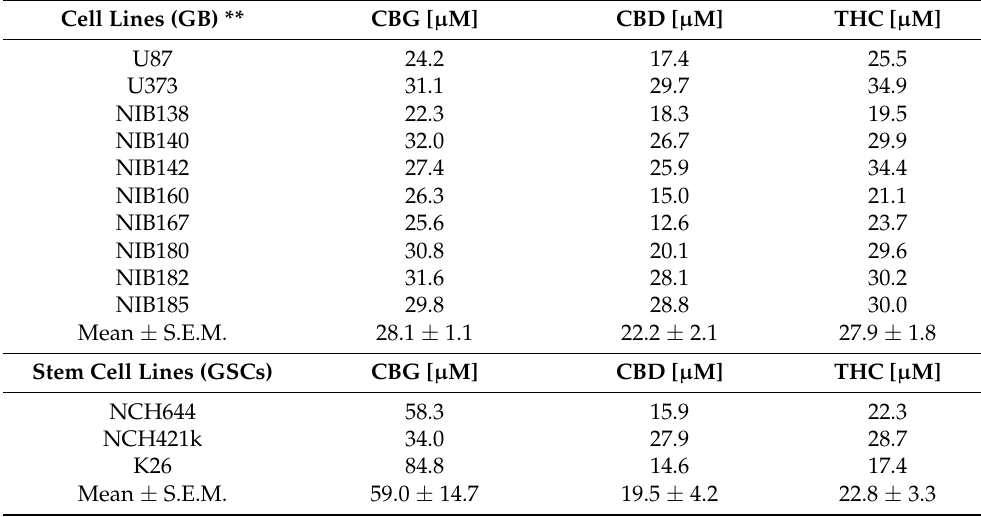
* IC50 values (expressed in µ M) for CBG-, CBD-, and THC-treated GB cells and GSCs were calculated from the half maximal inhibitory effects on GB and GSC viability using GraphPad Prism software, as described by Deng et al. [41] and in detail in the Methods section. Each value represents the mean of three independent biological assays (individual S.E.M. are shown in Figure 1). ** Besides commercially available cell lines, we have used patient-derived cell lines stablished at the N ational I nstitute of B iology ( NIB ) laboratory, labeled as NIB lines, systematically collected from a tumour bank termed “Gliobank” that is an international (Slovenia-Italy) glioma tissue bank (see Section 2.3).